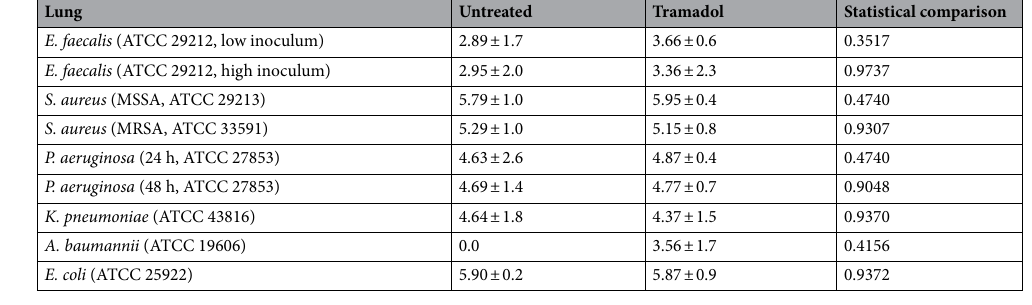
Table 2. Bacterial burden in lung tissue. Median bacterial burden as well as standard deviation expressed as log 10 cfu/g tissue in lung for the untreated and the tramadol-treated group for E. faecalis ATCC 29212 (low and high inoculum), S. aureus strains ATCC 29213 and ATCC 33591, P. aeruginosa ATCC 27853 (readout after 24 and 48 h), K. pneumoniae ATCC 43816, A. baumannii ATCC 19606, E. coli ATCC 25922. Statistical testing was performed using a Kolmogorov–Smirnov test. P values are indicated in the respective